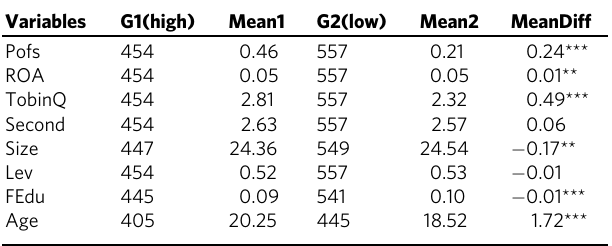
Table 4 The t -test table of the mean difference in the female employment